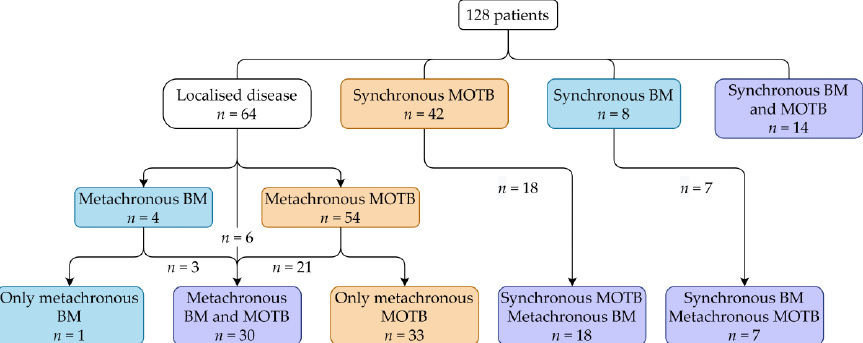
Figure 1. Clinical stage of included patients. Abbreviations: MOTB = metastasis other than bone, BM = bone metastasis.